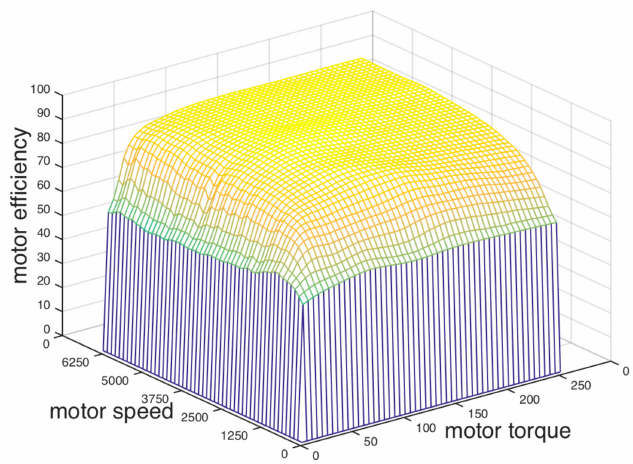
Figure 5. Efficiency characteristics of the BLDC.